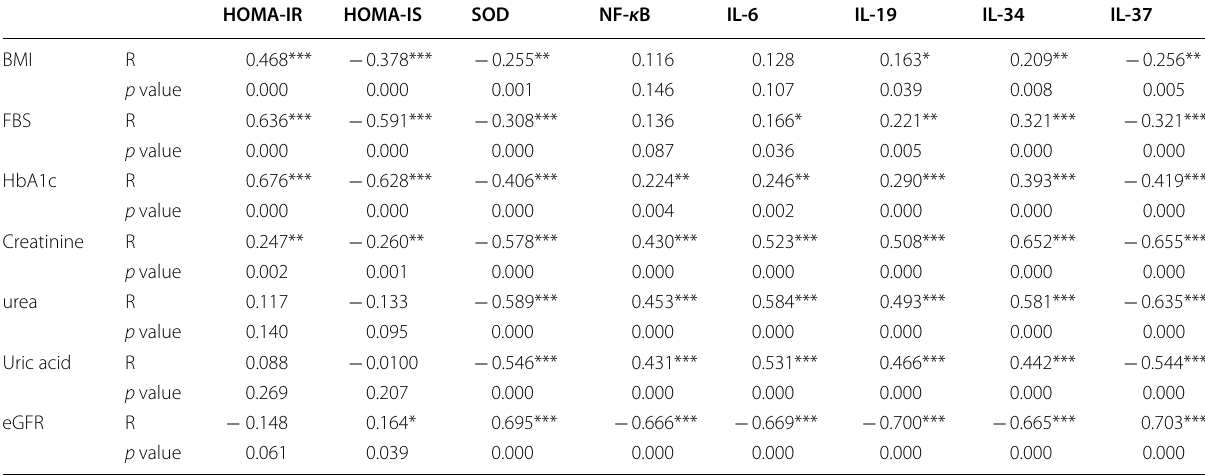
***correlation is significant at the 0.001 level; **correlation is significant at the 0.01 level; *correlation is significant at the 0.05 level, r : Pearson correlation, BMI: body mass index, FBS: fasting blood sugar, HbA1c: glycosylated hemoglobin, HOMA-IR: homeostasis model assessment for insulin resistance, HOMA-IS: homeostasis model assessment for insulin sensitivity, GFR: glomerular filtration rate, SOD: superoxide dismutase activity, NF- κ B: nuclear factor kappa